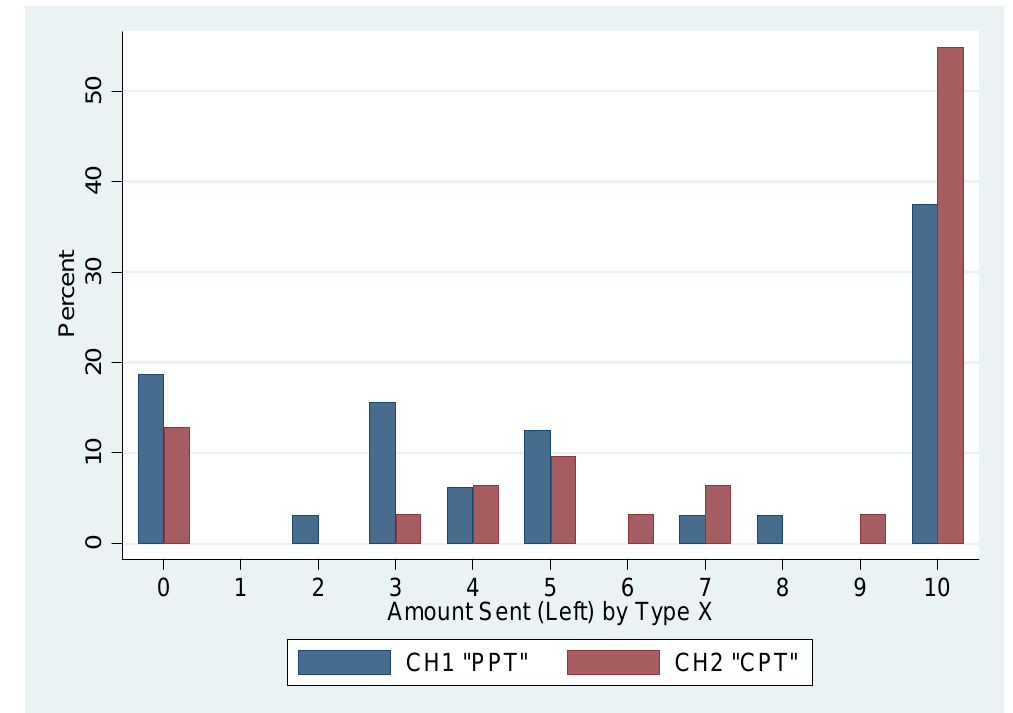
Figure 3. Comparison of Type X data for CH1 and CH2.